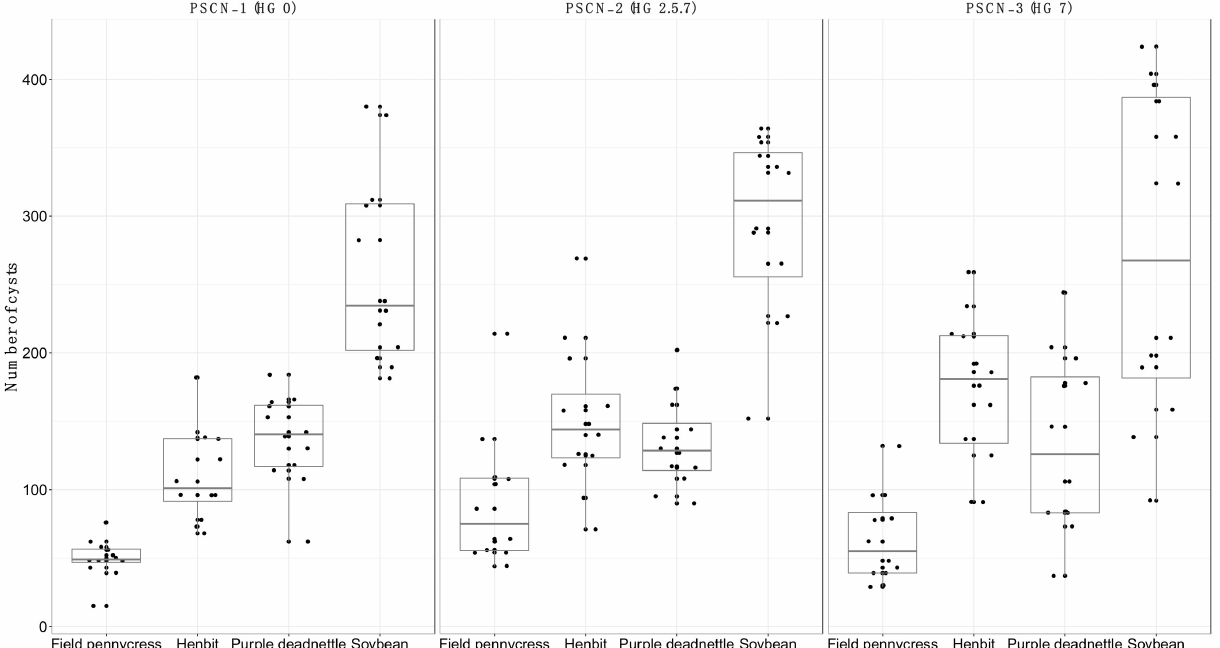
Figure 1. Boxplot showing the number of cysts on three weed hosts (field pennycress, henbit, and purple deadnettle) and the susceptible soybean check across three SCN populations (HG 0, 2.5.7, and